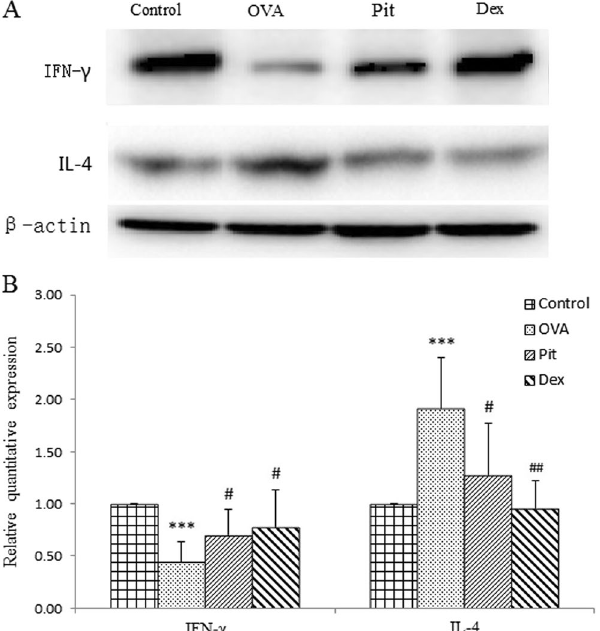
Figure 7. Effect of pitavastatin on IFN- γ and IL-4 expression in the lung tissues of asthmatic mice challenged with OVA. ( A ) Representative western blots showing IFN- γ expression in the different groups; ( B ) IFN-related optical densitometry results in the different groups. Control: Lung sections from mice treated with aerosolized PBS. OVA: Lung sections from mice challenged with OVA and treated with PBS. Pit and Dex: Lung sections from mice challenged with OVA and treated with pitavastatin and dexamethasone, respectively. *** P < 0.001 compared with the control group; # P < 0.05 compared with the OVA group; ### P < 0.01 compared with the OVA group. The results from three independent experiments are similar. The data are expressed as the mean ± SD (n = 7). Full-length blots are presented in Supplementary Figure